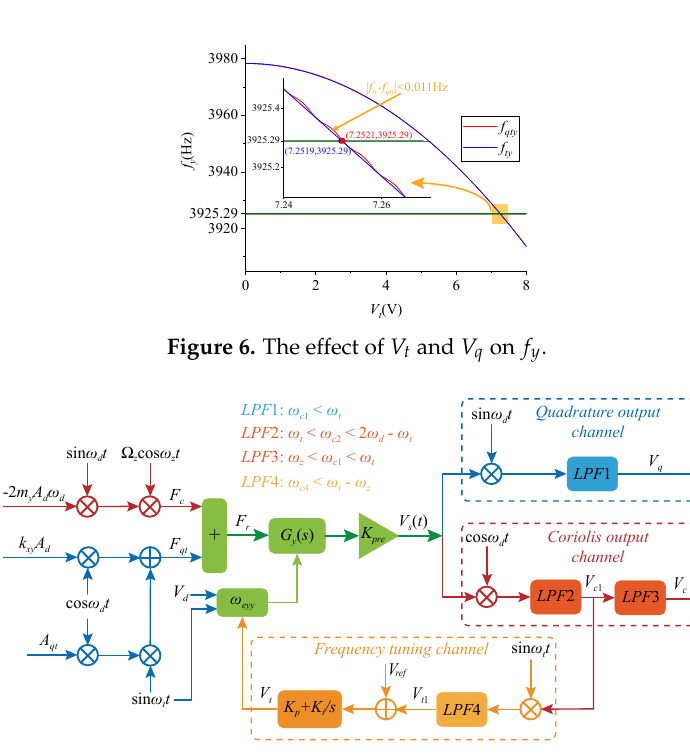
Figure 7. Schematic control loop for the automatic frequency tuning